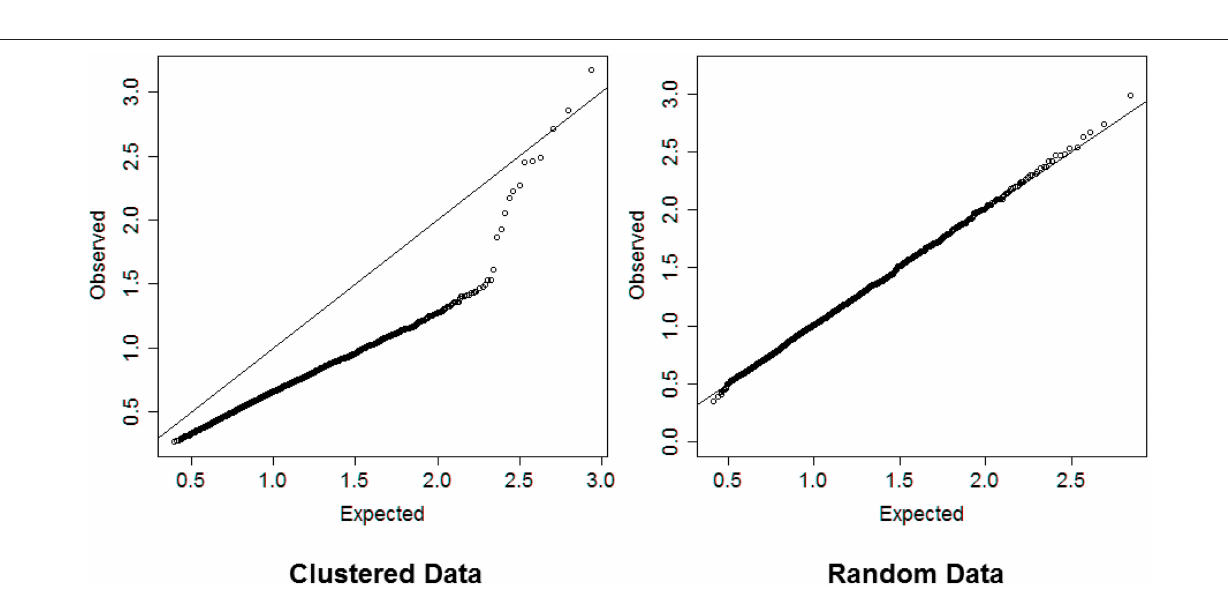
Frontiers in Genetics | www.frontiersin.org